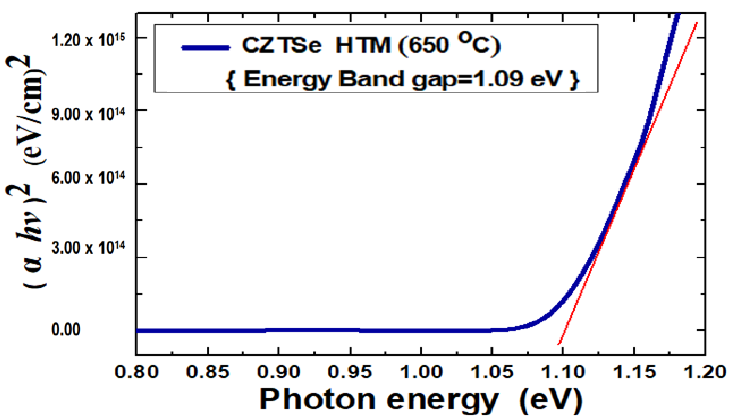
Figure 7. Graph of h ν versus ( α h ν ) 2 for measuring the optical energy bandgap of Cu 2 ZnSnSe 4 . It was determined by extrapolating the straight line portion to the photon energy axis.